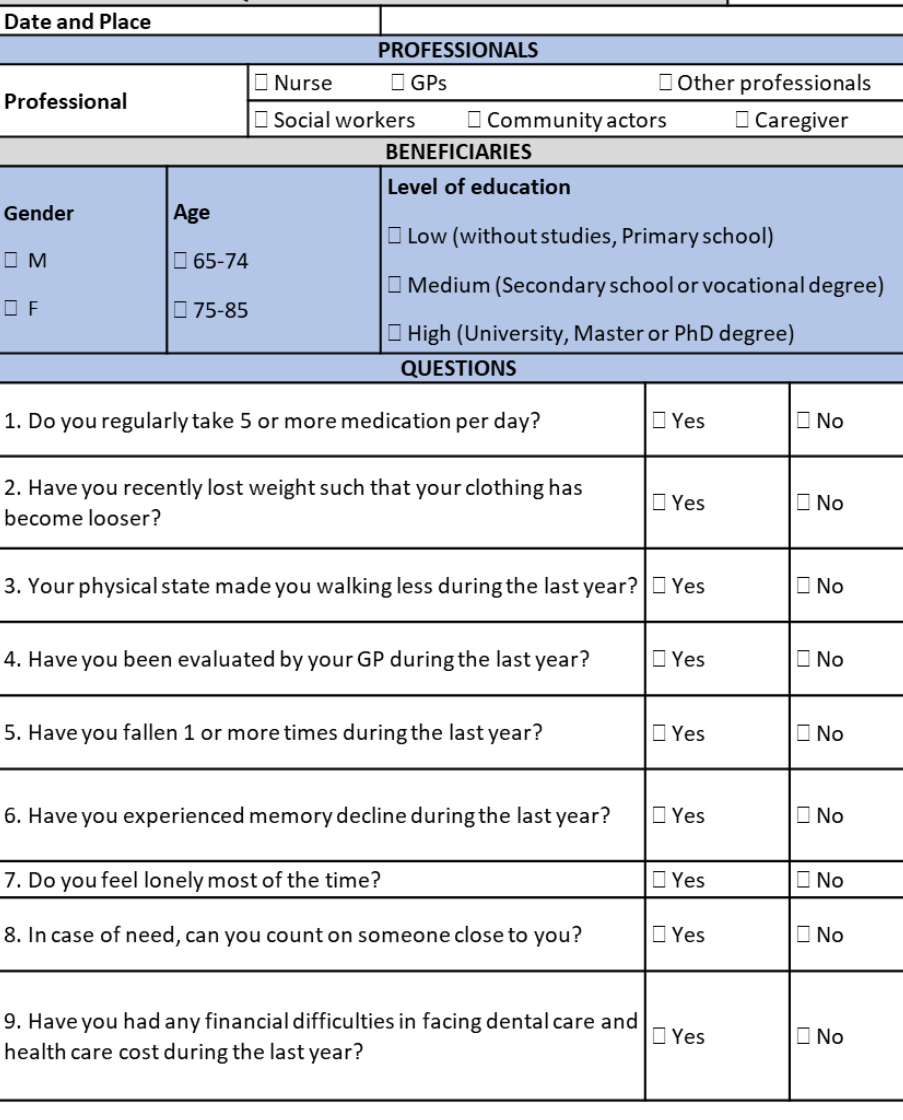
Figure 1. The SUNFRAIL screening tool.